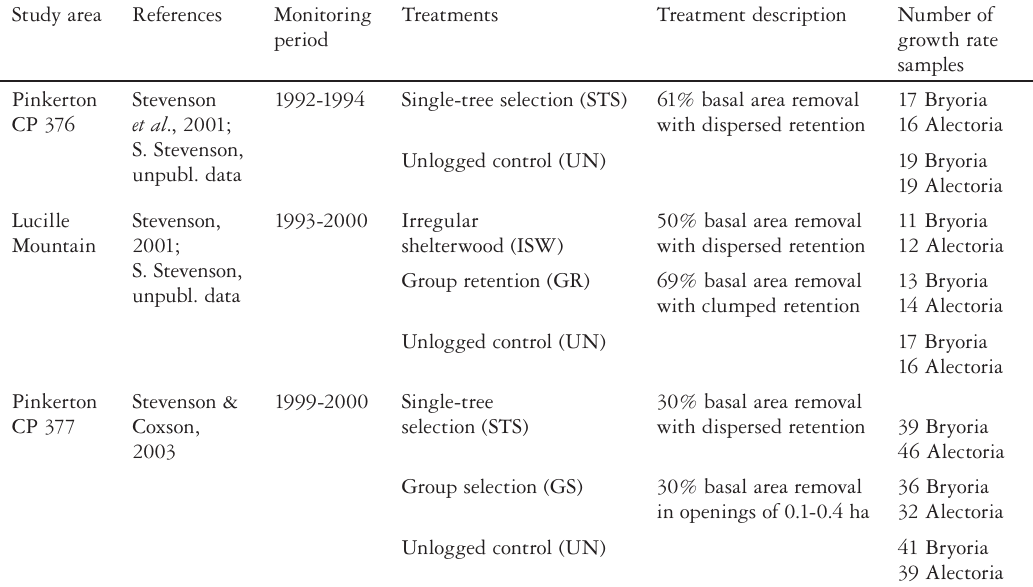
Table 2. Summary of lichen growth rate study areas Study